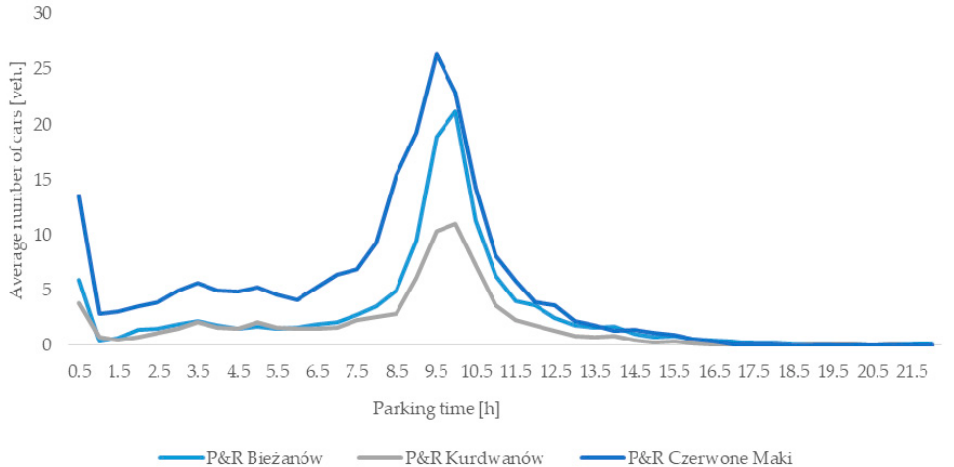
Figure 10. Distribution of vehicle parking time at P&R parking in Cracow on working days for all analyzed parking.